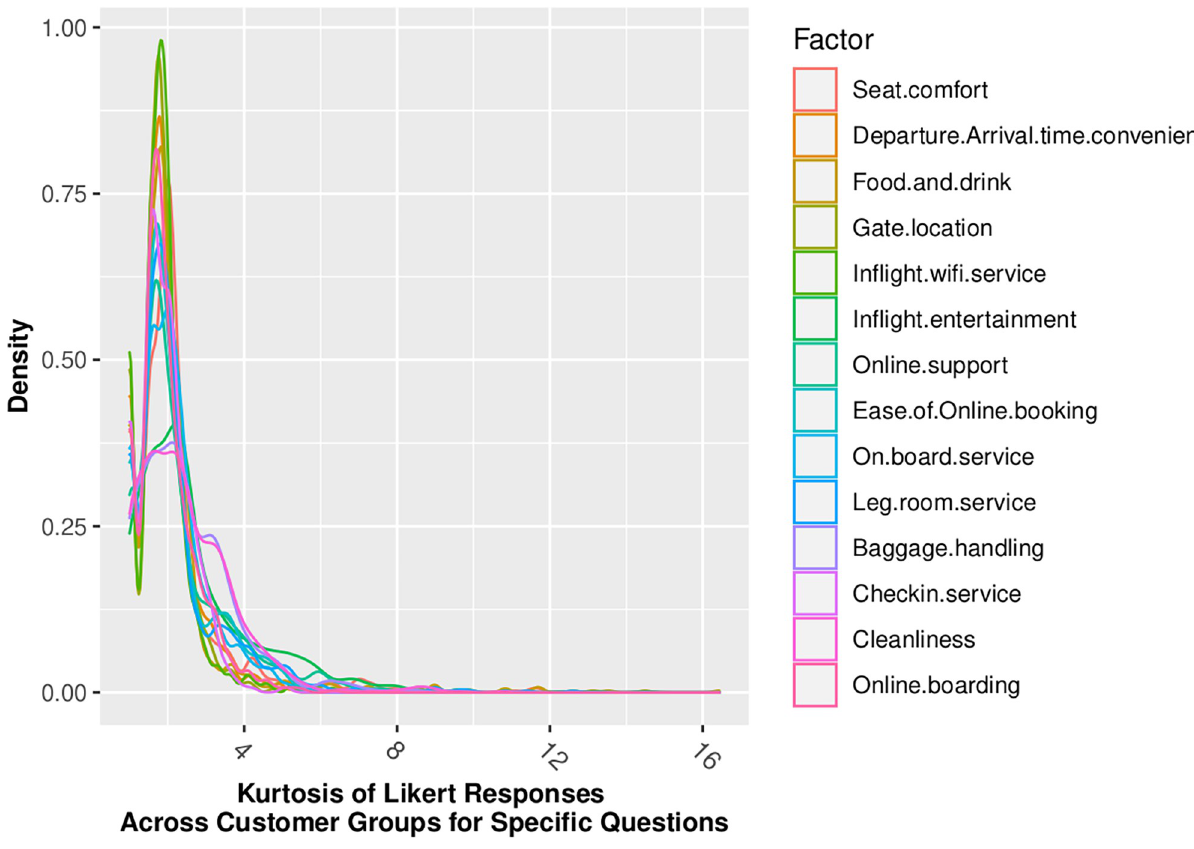
Fig 5. Kurtosis of likert responses by